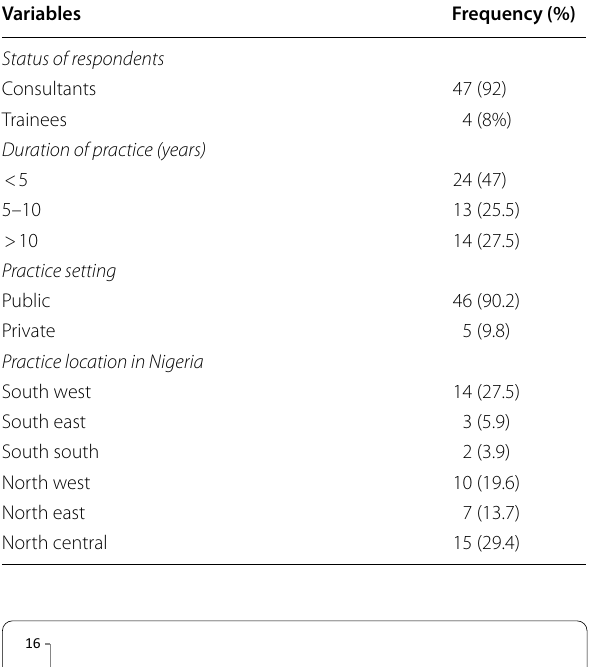
Table 1 Demographic characteristics of respondents